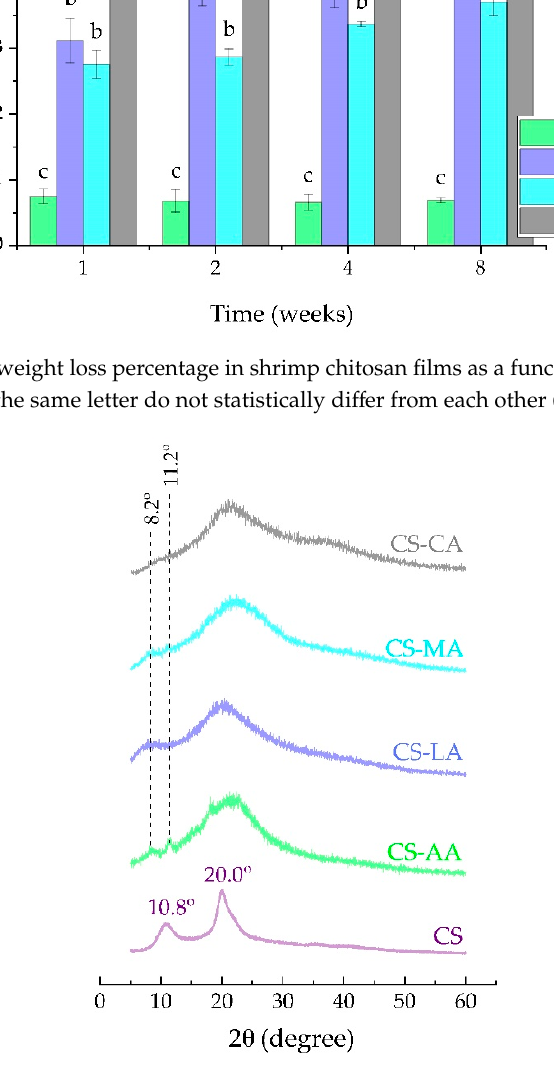
Figure 5. X-ray diffractograms of shrimp chitosan (CS) powder, CS-AA, CS-LA, CS-MA and CS-CA films.